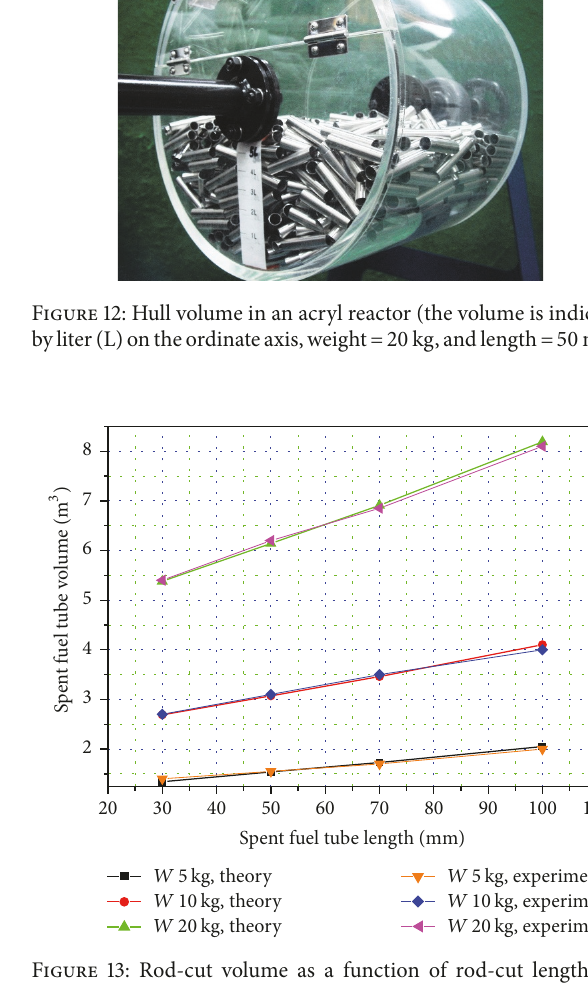
Figure 11: Reactor size as a function of hull length at a spent fuel load of 50 kg HM/batch.